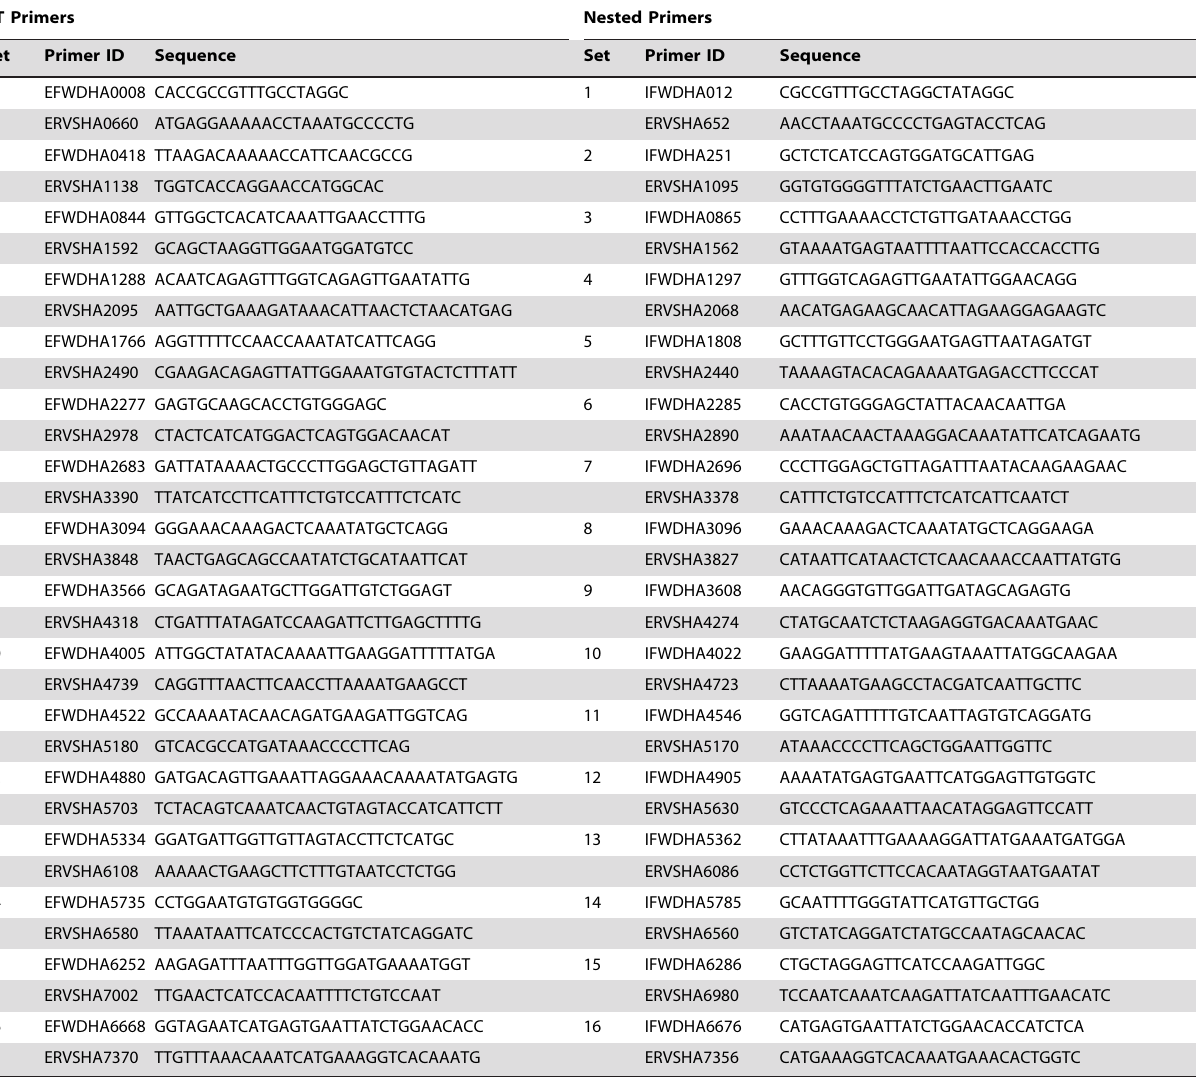
Table 1. Primers sequences for WG